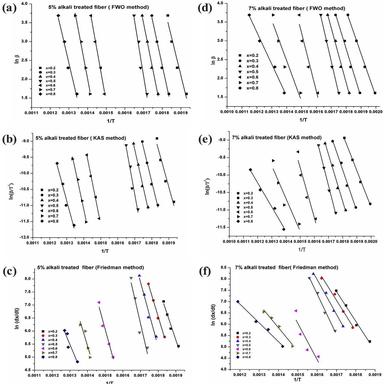
(a),(b,(c)FWO, KAS, Friedman plots of 5% treated fiber, (d), (e), (f) FWO, KAS, Friedman plots of 7%% treated fiber.